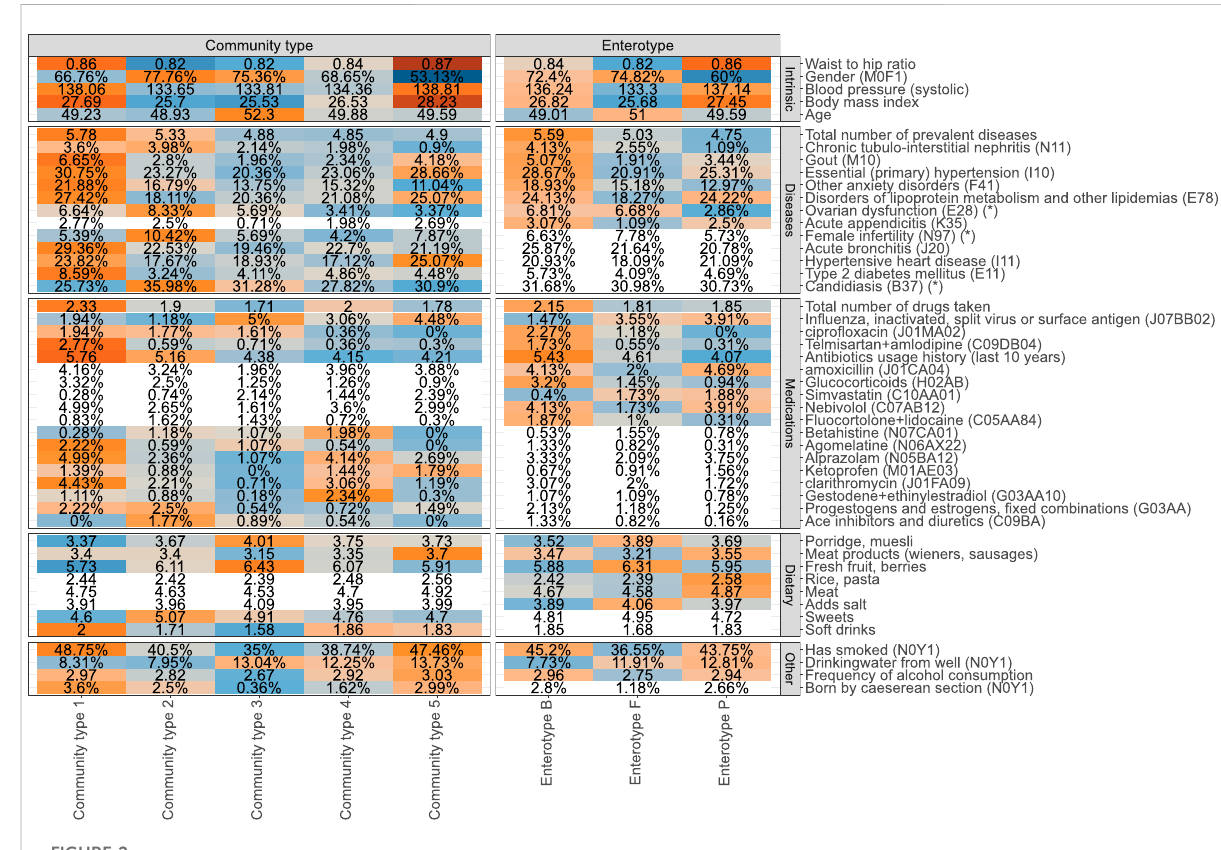
FIGURE 2 Phenotypeassociationswiththeenterotype(ET)modelandcommunitytype(CT)model(unadjustedanalysis).Colouredcellsrepresentfactors associated with CT and ET models respectively (FDR ≤ 0.1), and white cells indicate no statistically signi fi cant association (FDR > 0.1). Mean values or proportions (indicated by %) per cluster are shown. Blue colors indicate lower mean values or proportions for the cluster and orange color indicates higher values. Asterix (*) in the names of the factors indicate that a subpopulation consisting of women was used for calculating the displayed